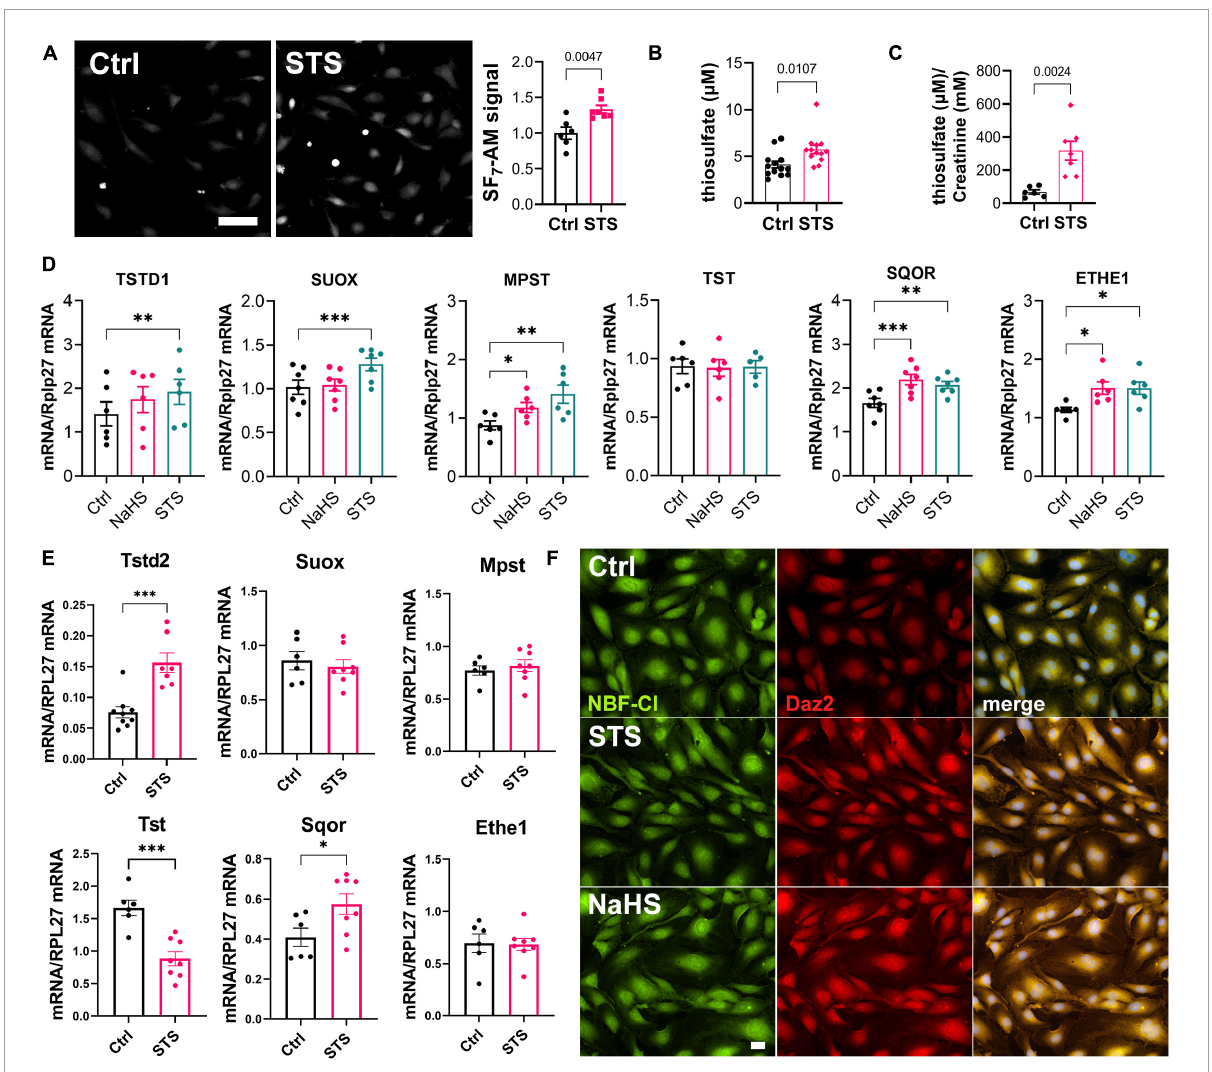
FIGURE2 Sodium thiosulfate (STS) leads to enzymatic production of hydrogen sulfide (H 2 S) and increases protein persulfidation. (A) H 2 S release measured by the SF 7 -AM probe in HUVEC exposed for 90 min to STS. Data are mean ± SEM of six independent experiments. * p < 0.05 as determined by bilateral unpaired t -test. Scale bar 20 µ m. (B) Plasma levels of thiosulfate in mice treated or not (Ctrl) for 2 weeks with 4 g/L STS. Data are mean ± SEM of 12 animals per group. p = 0.011 as determined by bilateral- unpaired t -test. (C) Urine levels of thiosulfate, normalized to creatinine levels, in mice treated or not (Ctrl) for 2 weeks with 4 g/L STS. Data are mean ± SEM of 6 or 7 animals per group. p = 0.0035 as determined by bilateral- unpaired t -test. (D) mRNA expression in HUVEC exposed for 4 h to NaHS (100 µ M) or STS (3 mM). Data are mean ± SEM of six independent experiments. * p < 0.05, ** p < 0.01; *** p < 0.001 as determined by repeated measures one-way ANOVA with Dunnett’s post hoc test. (E) mRNA expression in gastrocnemius muscle of mice treated for 1 week with 4 g/L STS. Data are mean ± SEM of 6–8 animals per group. * p < 0.05, ** p < 0.01; *** p < 0.001 as determined by bilateral- unpaired t -test. (F) In situ labeling of intracellular protein persulfidation assessed by DAz-2:Biotin-Streptavidin-584 (red), normalized to NBF-adducts fluorescence (green), in HUVEC exposed for 4 h to NaHS (100 µ M) or STS (3